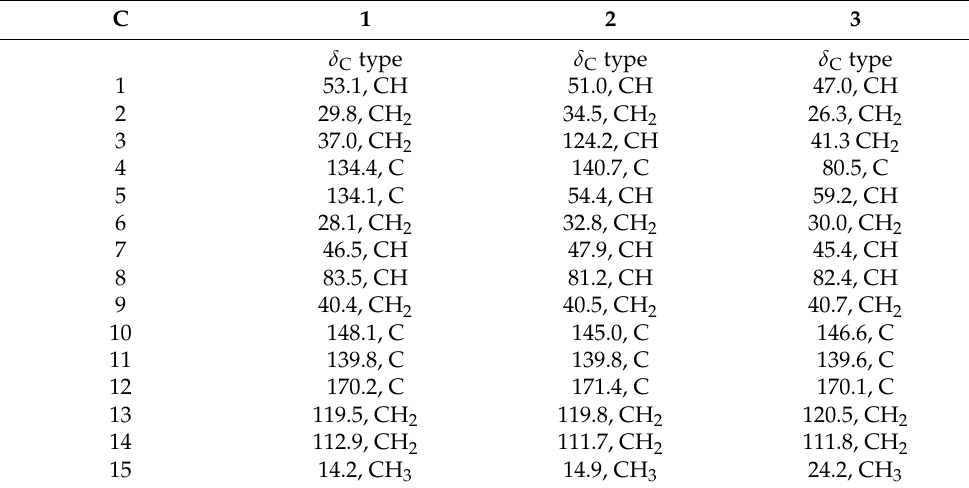
Table 2. 13 C NMR data a,b in CDCl 3 for centaurolide A ( 1 ) and B ( 2 ), and inuviscolide ( 3 ) c